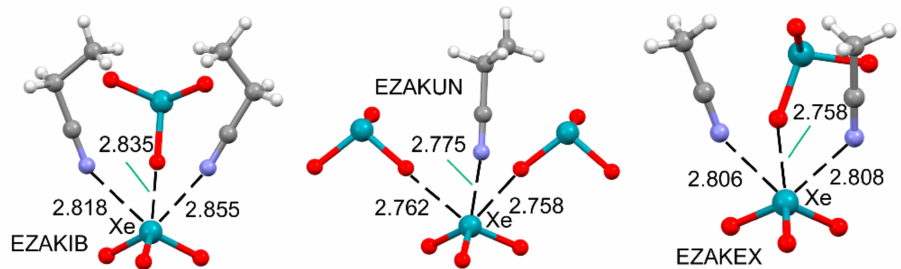
Figure 12. Partial views of the X-ray structures corresponding to CSD reference codes EZAKIB ( left ), EZAKUN ( middle ), and EZAKEX ( right ) corresponding to bis(propionitrile)-trioxo-xenon, trioxo-propanenitrile-xenon, and bis(acetonitrile)-trioxo-xenon, respectively. Distances in Å.